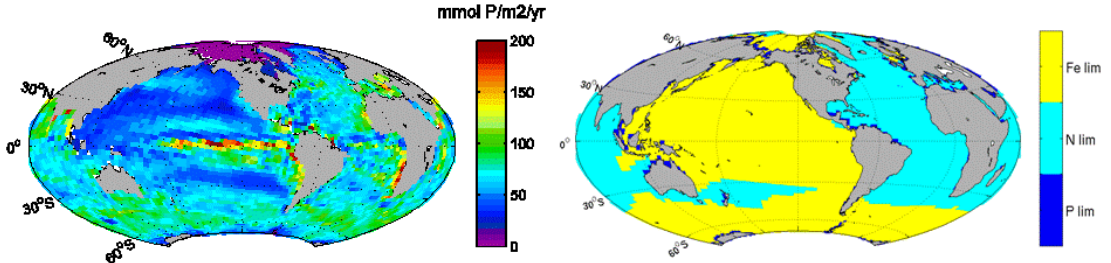
Fig. 4. Left, annually integrated photosynthesis in the euphotic ocean layer, the photosynthesis is expressed in mmolPm − 2 yr − 1 . Right, limiting nutrient driving the photosynthesis in the surface layer.